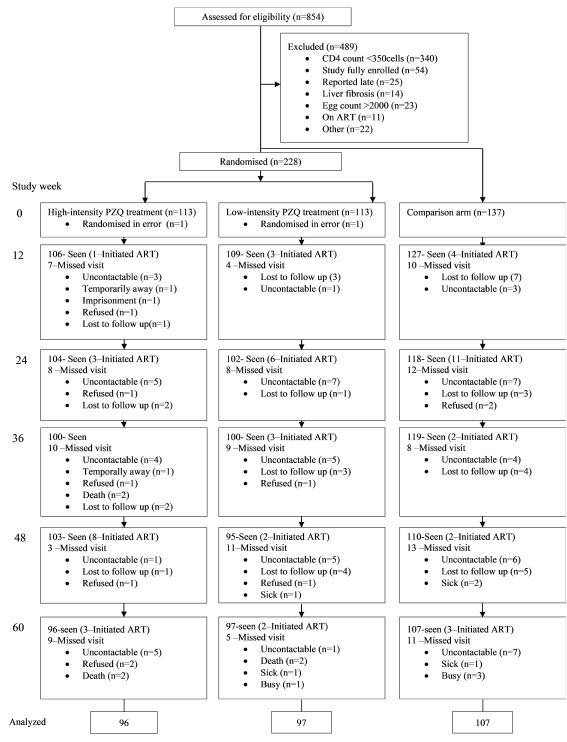
CONSORT flow diagram.PZQ - praziquantel.